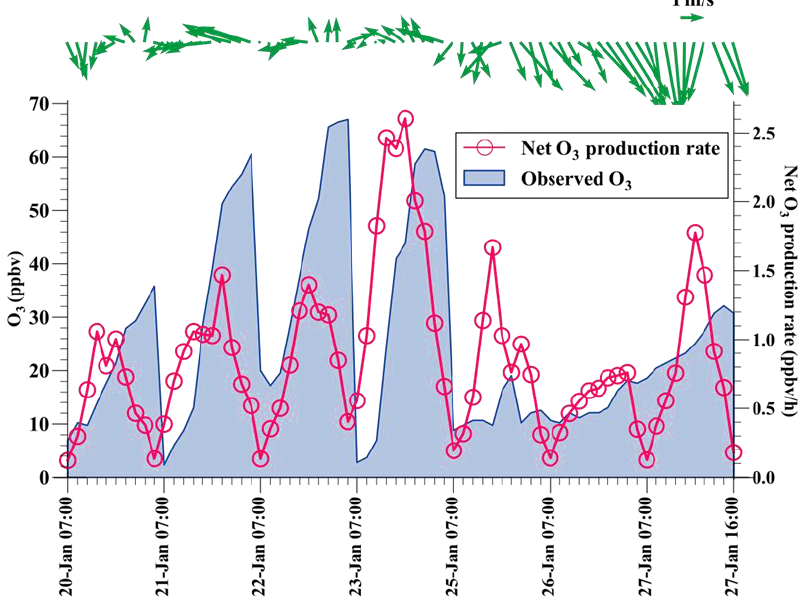
Figure 4. Variations of the net O 3 production rate and observed O 3 during 07:00 a.m.–16:00 p.m. from 20 to 27 January, excluding 24 January. Green arrows denote wind fields.